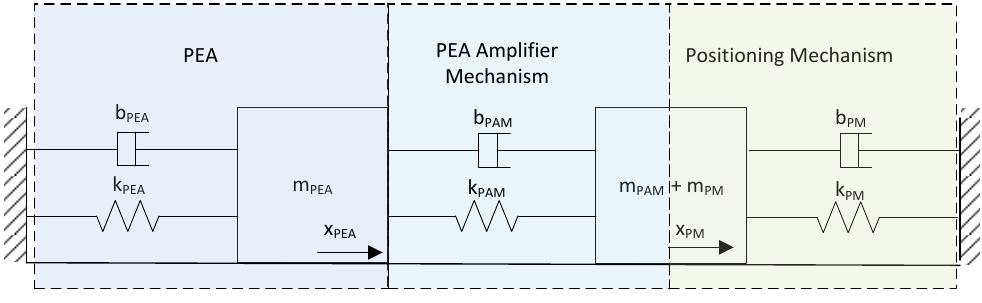
Figure 2. Positioning system mechanical model.